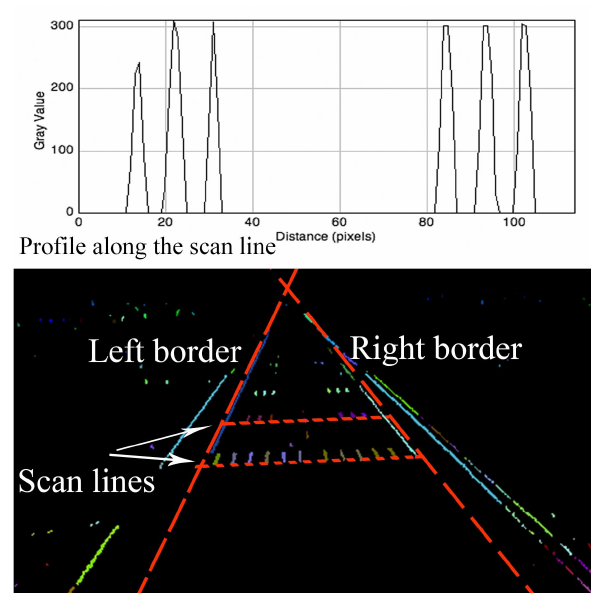
Figure 5. Process of runway threshold and touchdown zone markings detection